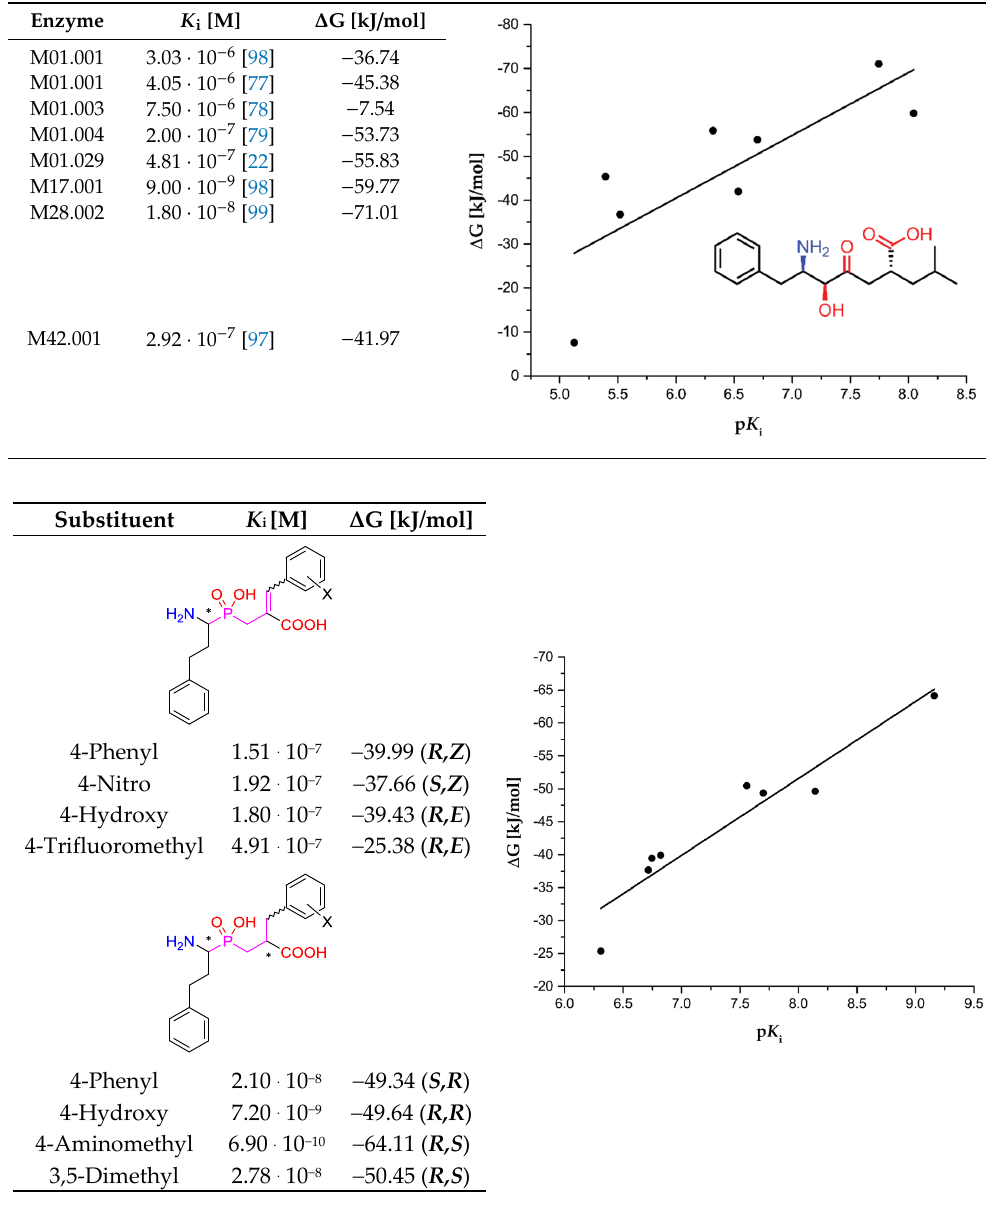
Figure 12. Correlation plot of inhibitory activity of phosphinic dipeptide and dehydrodipeptide analogs (p K i ) reported for human aminopeptidase N [8,10] with the corresponding values of the calculated free Gibbs energy (R 2 = 0.91).